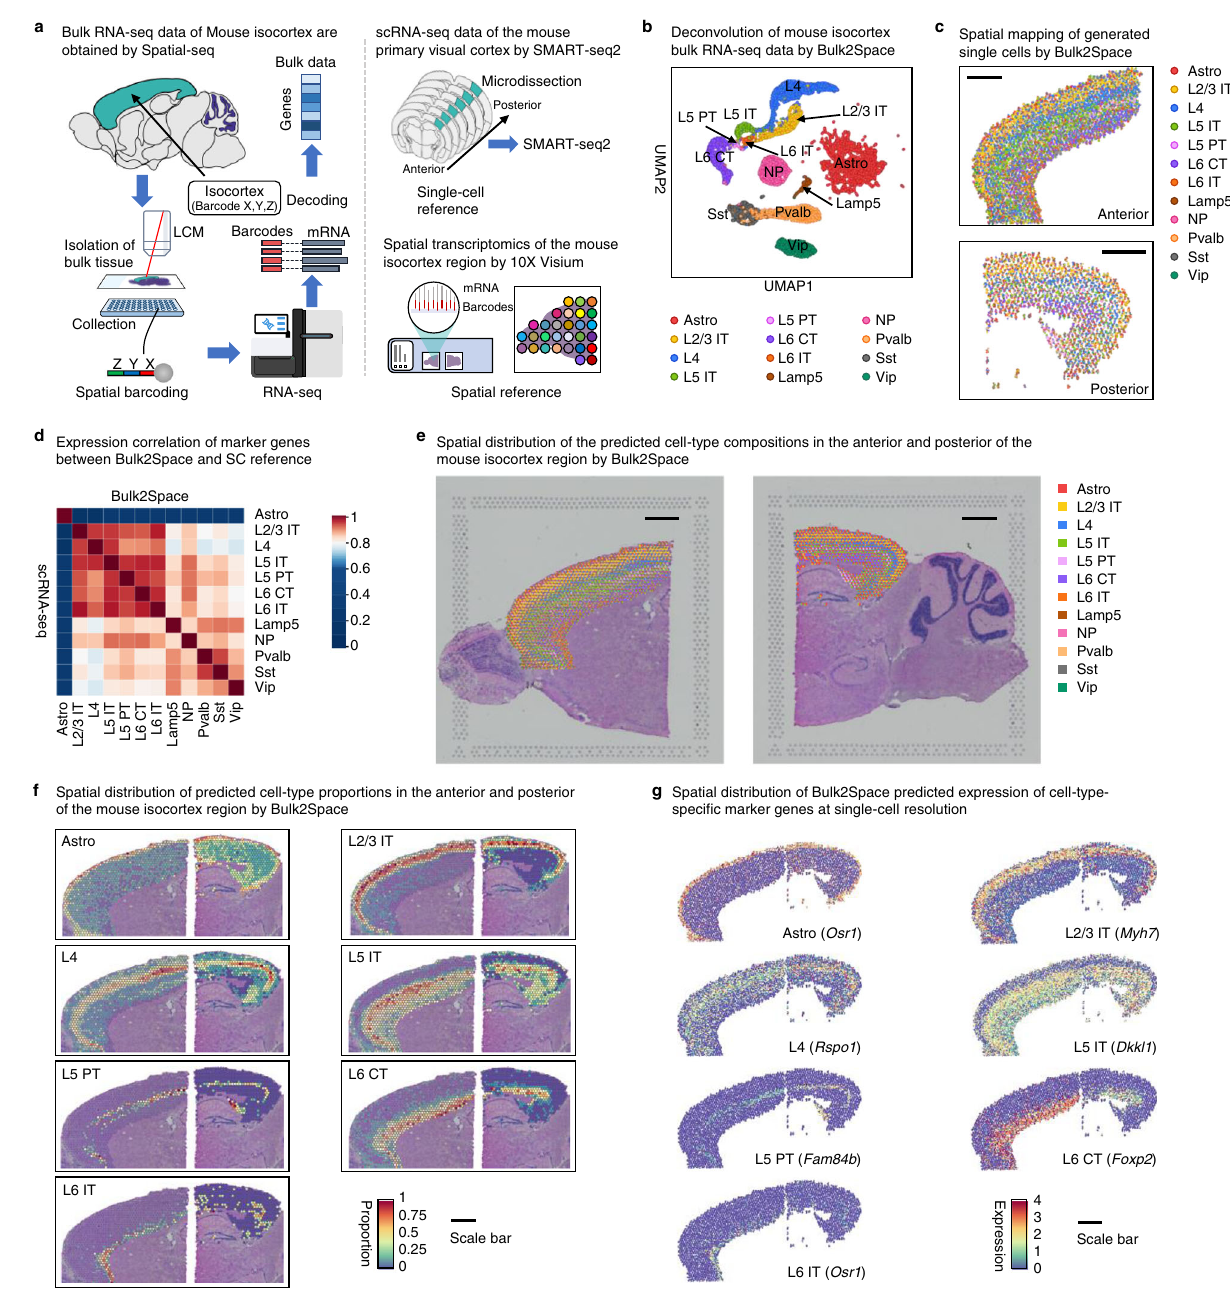
Fig. 4 | Spatially resolved single-cell analysis of the mouse isocortex bulk data by Bulk2Space. a The resources of the bulk transcriptome data, single-cell refer- ence, and spatial reference. The bulk RNA-seq data of the mouse isocortex was sequenced using our in-house developed Spatial-seq which combines LCM and spatial barcoding strategies. The single-cell reference data is derived from scRNA- seq of a collection of consecutive mouse primary visual cortex sections from anterior to posterior. The spatial reference data is obtained from an open-access databaseusingthe10XVisiumapproach. b Thedeconvolutionresultsofthemouse isocortex bulk data by Bulk2Space. The UMAP layout showed the clustering space